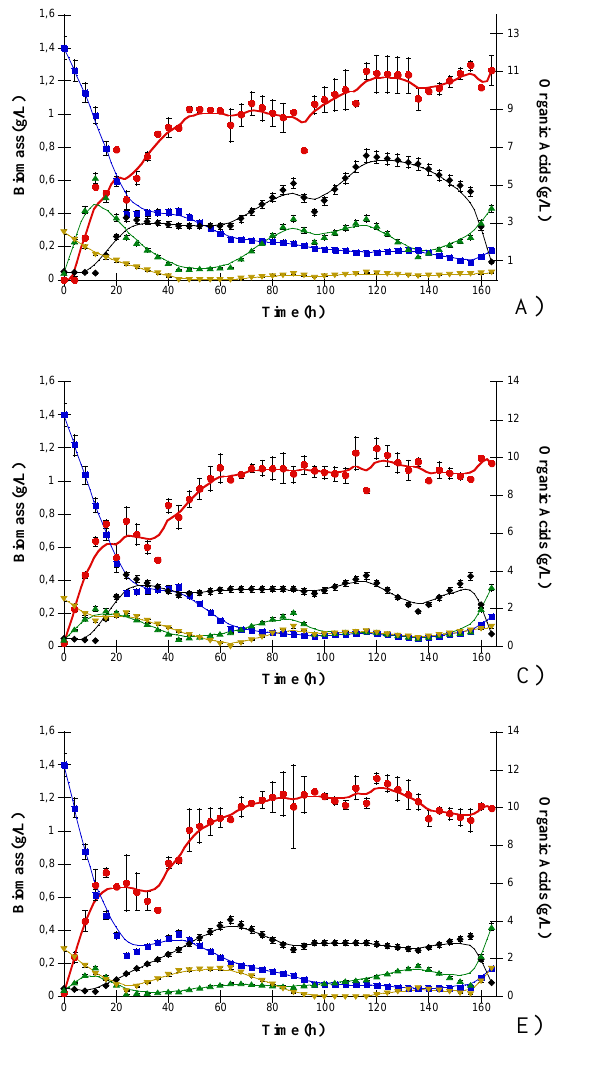
Figure 3. Consortium culture patterns of organic acid consumption: HLac ( ), HAc ( ), HPr ( ), HBu ( ), biomass ( λ ), bioH 2 ( ) and PHA production (bars) obtained by NPC-C4 in the upper panel ( A , B ), BNPC-C4 in the middle panel ( C , D ), and the designed consortium ( C. pasteurianum , R. palustris and S. w ) in the lower panel ( E , F ).